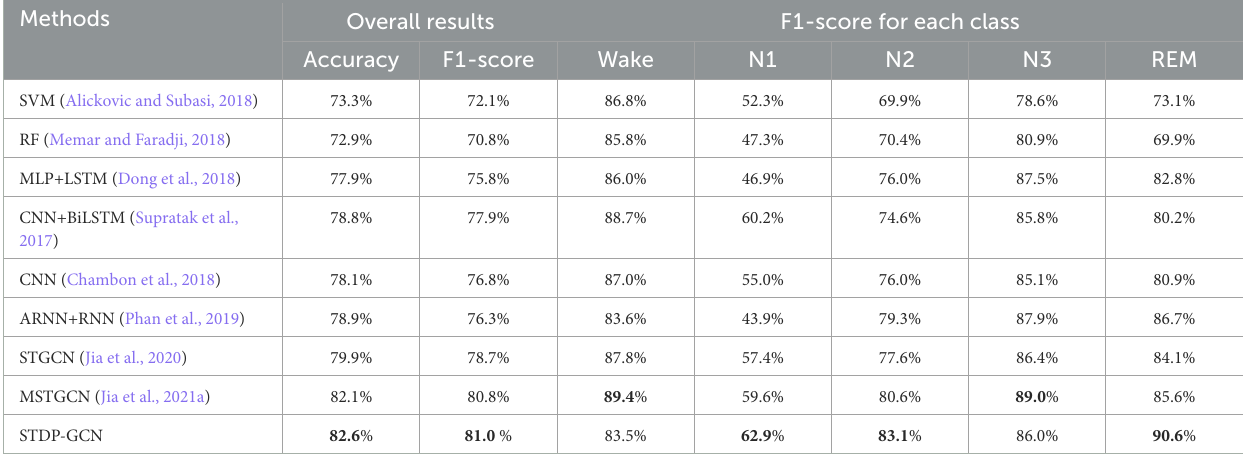
TABLE 2 Overall results comparison on ISRUC-S3. Methods